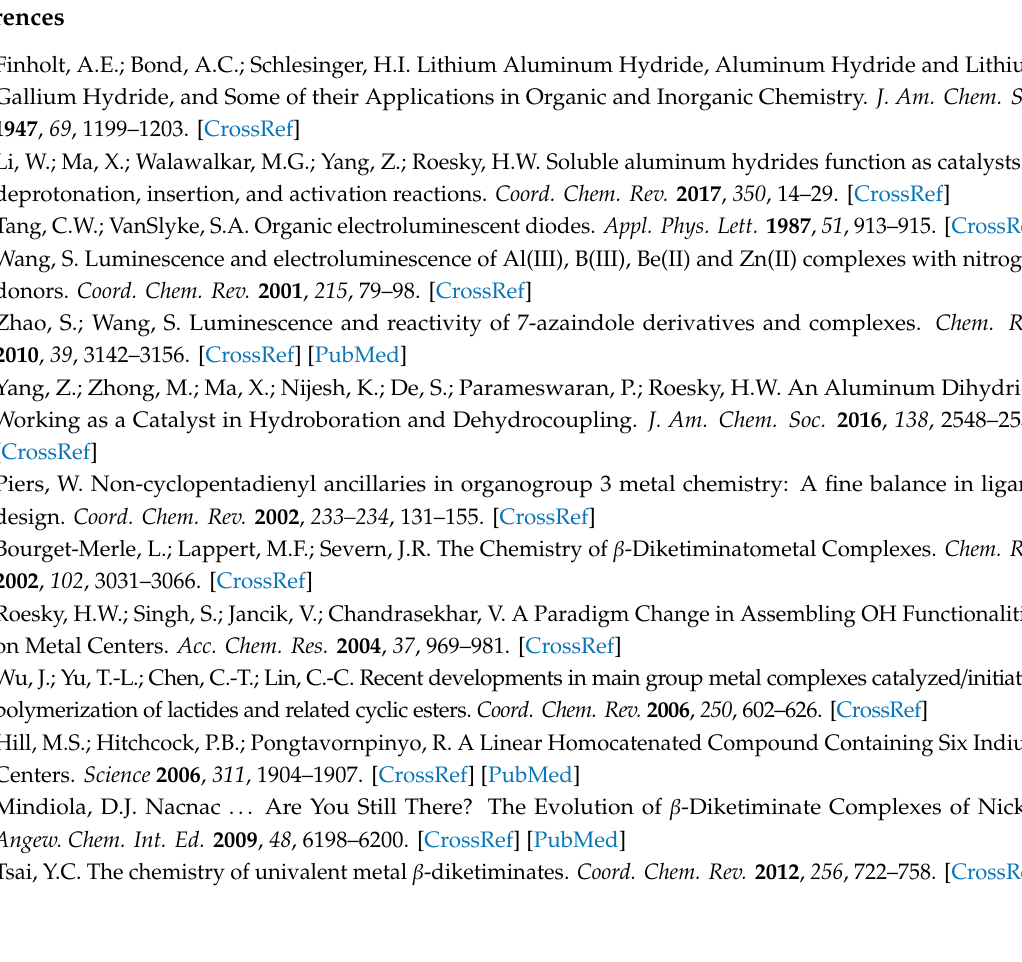
Figure S1: (a) 1 H and (b) 13 C{ 1 H} NMR spectra of LAlH in CDCl 3 , Figure S2: (a) 1 H and (b) 13 C{ 1 H} NMR spectra of LAlH in C 6 D 6 , Figure S3: 27 Al{ 1 H} NMR spectrum of LAlH in C 6 D 6 . Al(NO 3 ) 3 · 9H 2 O in D 2 O was used as an external standard (0 ppm), Figure S4: Packing diagram of LAlH viewed along with (a) a and (b) b axes. All hydrogen atoms were omitted for clarity. Isopropyl groups were shown in wireframe. Legends: red bar, a axis; green bar, b axis; and blue bar, c axis. Key to atom color: carbon, copper and green; aluminum, magenta; and nitrogen, blue, Figure S5: UV–Vis absorption spectrum (blue circles) and the fitted curve (black line), Figure S6: Fluorescence decay curves of LAlH (a) in the crystalline state at r.t. detected at 450 (cyan triangles) and 481 nm (blue circles) and (b) in the solution state at 80 K. Fitted curves were shown as solid lines, Figure S7: Simple Jablonski diagram for LAlH , Figure S8: Phosphorescence spectra of LAlH at 80 K in (a) the solution and (b) crystalline states. The spectra were recorded after 1.0 ms from the excitation. Insets show the corresponding phosphorescence decay curves, Figure S9: Deconvoluted photoluminescence spectrum of LAlH in the solution state at 80 K, Figure S10: Superimposed structures of (a) the single-crystal (blue) and the S 0 optimized (magenta) structures, and (b) S 0 (magenta) and S 1 (green) optimized structures, Table S1: Selected X-ray data, collection and refinement parameters for LAlH , Table S2: Fitted parameters for the UV–vis spectrum, Table S3: Parameters for estimation of k FL0 , Table S4: Fitted parameters for fluorescence lifetime measurements of the crystals at r.t., Table S5: Phosphorescence lifetimes of LAlH at 80 K, Table S6: Results of deconvolution of the photoluminescence spectrum, Table S7: Optimized geometry of LAlH at the S 0 state, Table S8: Optimized geometry of LAlH at the S 1 state, Table S9: Result of TD-DFT calculation for LAlH at the S 0 geometry, Table S10: Result of TD-DFT calculation for LAlH at the S 1